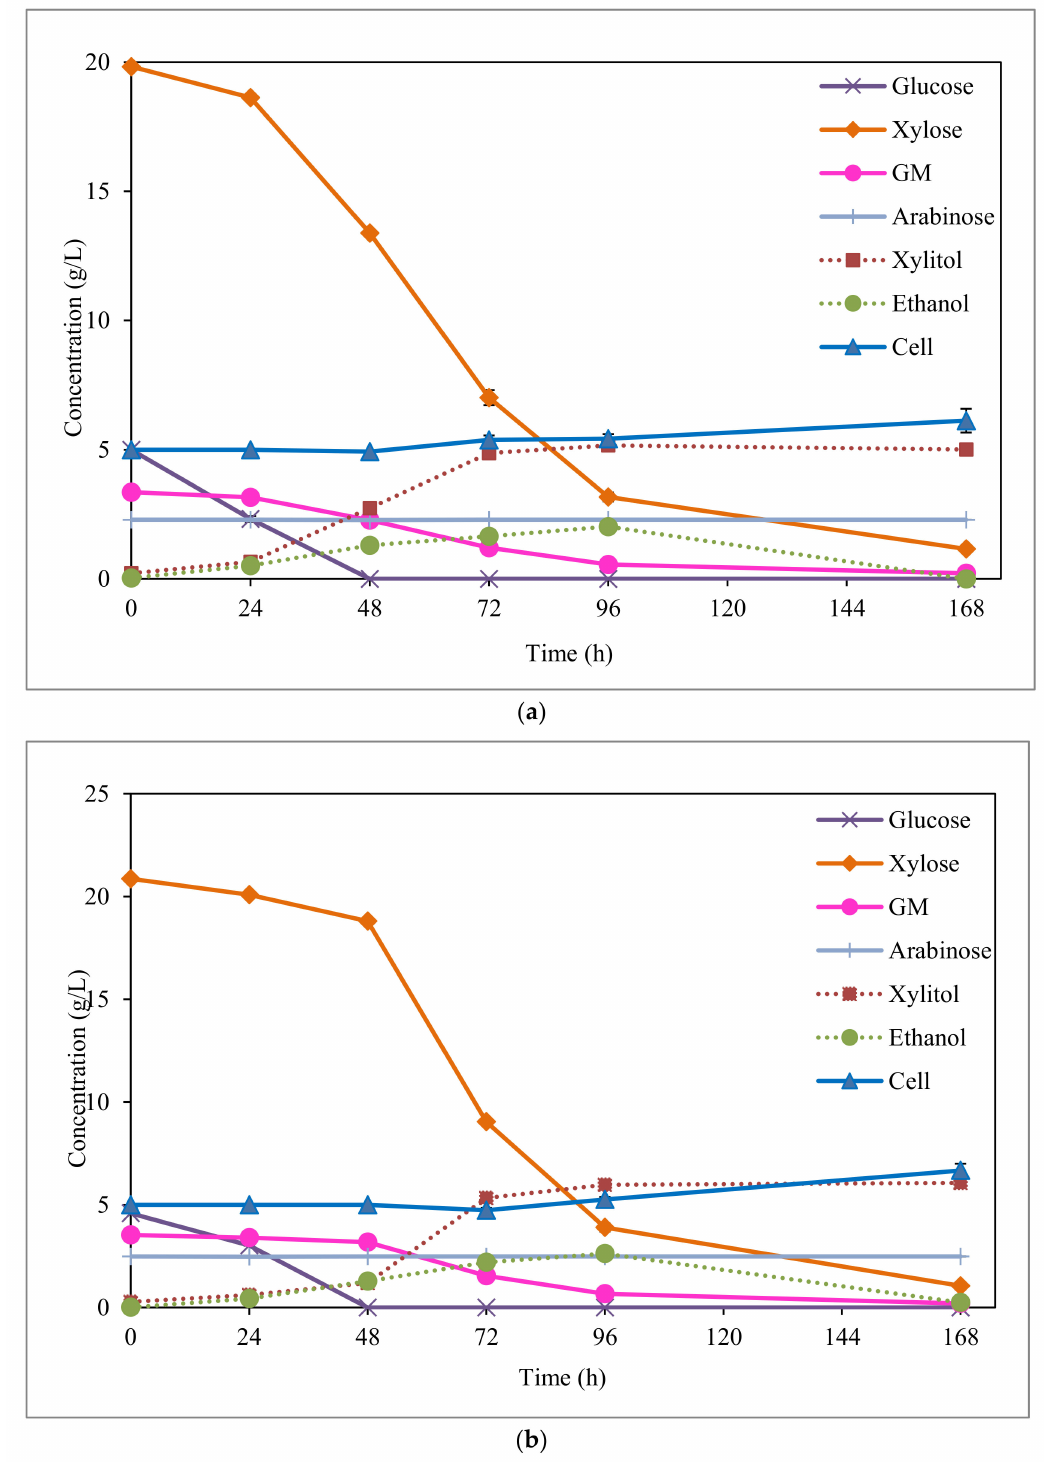
Figure 3. Fermentation of EOP acid hydrolysate by C. boidinii after detoxification by activated charcoal; and ( a ) ion-exchange resin ( b